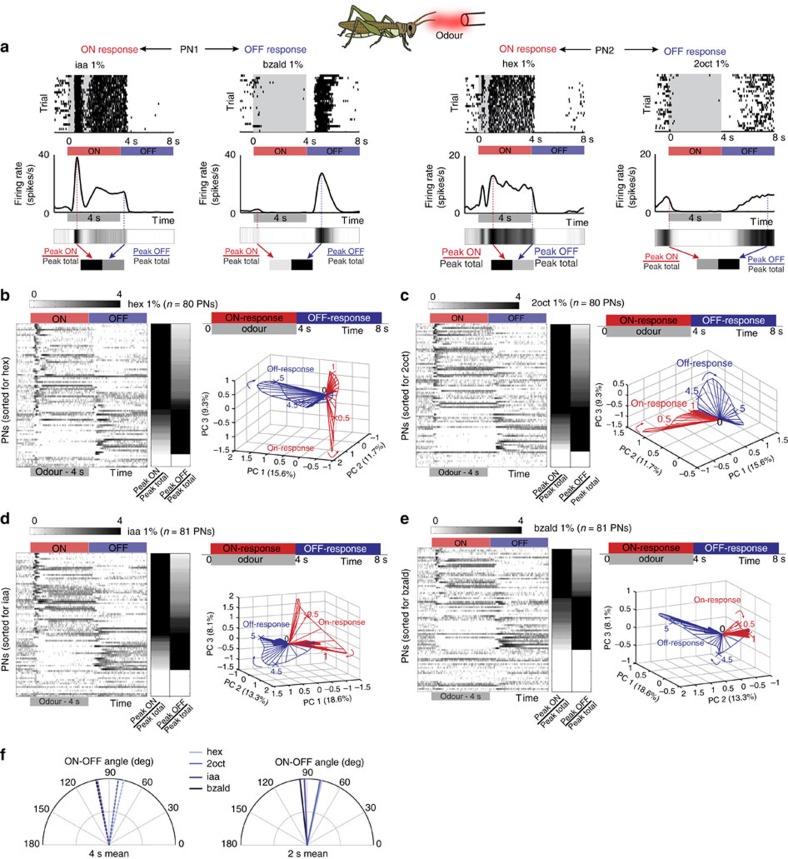
Odour-evoked ON versus OFF neural responses are flexible orthogonal set.(a) Raster plots of spiking activity of two different olfactory projection neurons (PNs; in the insect antennal lobe). Each row corresponds to a single trial, shaded grey box corresponds to 4 s of odour exposure. Twenty-five consecutive trials are shown for each PN. Firing rates in non-overlapping 50 ms time bins (with five point smoothing) are shown below the raster plot. Note there are two prominent PN response categories. (i) ON responses: increase in spiking activity limited to the period of stimulus exposure (PN1–iaa 1% and PN2–hex 1%), (ii) OFF responses: spiking activity is suppressed during odour presentation period but raises above pre-stimulus levels after odour termination (PN1–bzald 1% and PN2–2oct 1%). Same PN can have either ON or OFF response depending on odour identity. Colourbar represents normalized firing rate. The peak responses during stimulus exposure (during ON response window) and following its termination (during OFF response window) are identified. ‘Peak total' indicates the maximum response taking into account both epochs. (b) Left, Mean PN firing rates (50 ms time bins; averaged across 25 trials) are shown for hexanol (hex) delivered at 1% dilution (v/v). Each row represents the mean firing rate of one PN. Red and blue bars denote Stimulus ON and Stimulus OFF periods respectively. All PN responses are plotted on log scale for comparison. PNs are ordered based on the difference between the peak firing activities observed during the ON and OFF response epochs. Non-responsive neurons or with statistically insignificant responses are shown at the bottom. The normalized peak firing rates during the ON and OFF response periods are shown to the right of the panel. Firing rate increases from light to dark. Non-responsive neurons are shown in white. Right, Olfactory PN spiking activities pooled across locusts are visualized after dimensionality reduction using linear principal component analysis (PCA; see Methods). The percentage of variance captured along the first three principal components is plotted for all PN responses on left. The trajectory traced by the ensemble during the 4 s of stimulus exposure (‘ON response') is plotted in red and post-stimulus termination in blue (‘OFF response'). Numbers near response trajectories indicate time in seconds since odor onset, and the arrows indicate the direction of evolution over time. (c–e) Similar plots as in b for three other odorants: 2-octanol (2oct), isoamyl acetate (iaa) and benzaldehyde (bzald). All odorants are at their 1% dilutions (v/v in mineral oil). (f) Angular distances between the mean ON and OFF responses of olfactory PNs (high-dimensional vectors of PN spike counts) are shown for all four odorants using two different time windows (4 and 2 s).